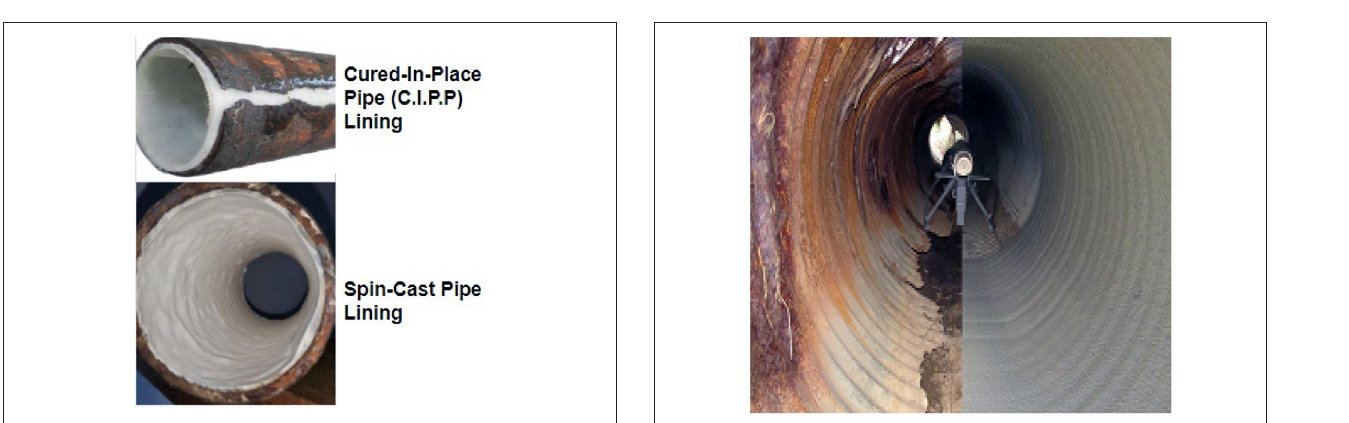
FIGURE 2 | Machine pipe renewal for SAPL. https://www.estormwater.com/ pipe-distribution/pipeline-rehabilitation-products.